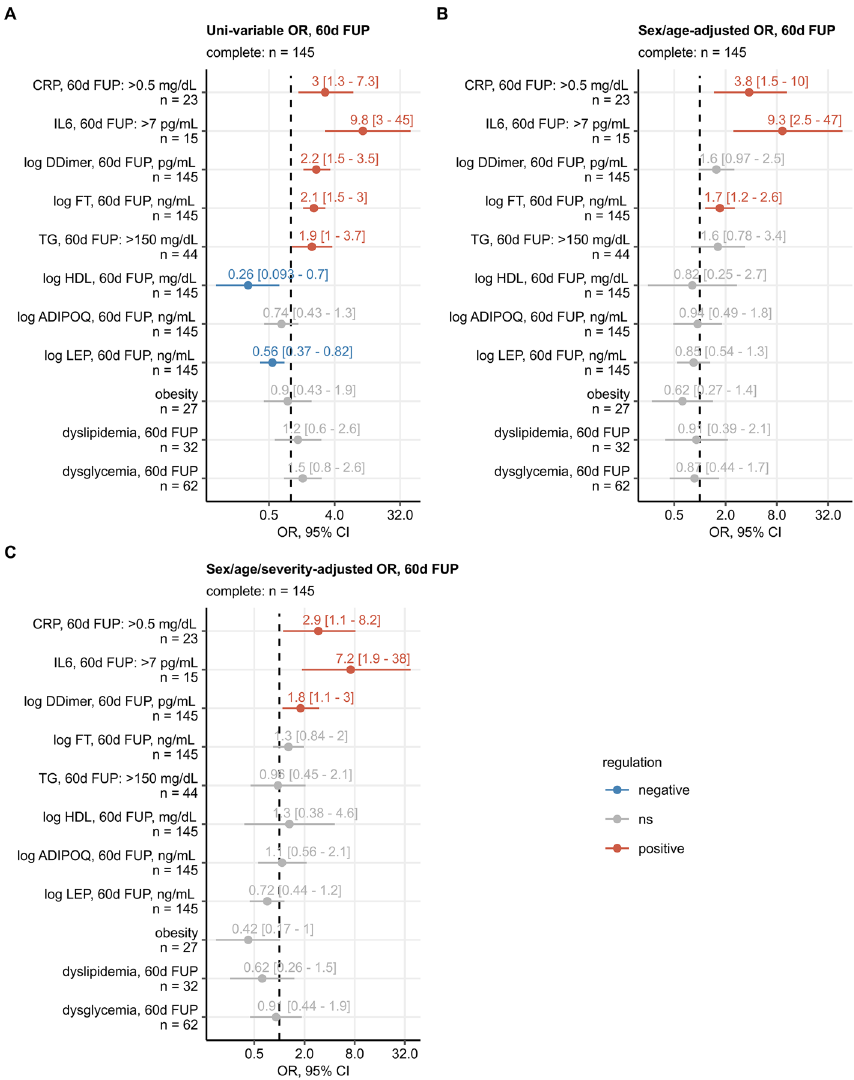
Figure 6. Logistic ordinal modeling of chest CT abnormality severity at the 60-day follow-up as a function of inflammatory and metabolic parameters. Chest CT abnormalities were classified as none (CT severity score [CTSS]: 0), mild (CTSS: 1–5), moderate (CTSS: 6–10) and severe (CTSS: ≥ 11). Effects of inflammatory (C-reactive protein [CRP], interleukin 6 [IL6], d-dimer [DDimer], ferritin [FT]), metabolic biomarkers (triglycerides [TG], high-density lipoprotein [HDL], adiponectin [ADIPOQ], leptin [LEP]) and metabolic disorders (obesity, dyslipidemia and dysglycemia) on chest CT abnormality severity at the 60-day follow-up were assessed by ordinal logistic regression. Odds ratio (OR) with 95% confidence intervals (CI) for the explanatory variables in univariable models ( A ), models adjusted for age class and sex ( B ) and models adjusted for age class, sex and acute COVID-19 severity ( C ) are shown in Forest plots. Point colour codes for significance and model estimate sign. Points are labeled with OR and 95% CI